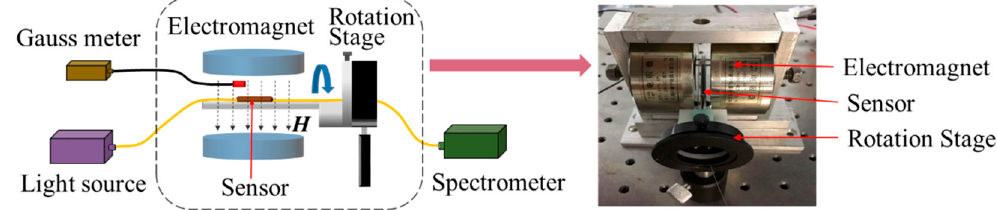
Figure 6. Schematic diagram of experimental setup and photograph of main components, including electromagnet, sensor and rotation stage.